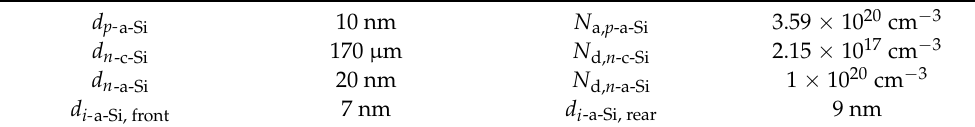
Table 2. Final optimized parameters of HIT solar cells